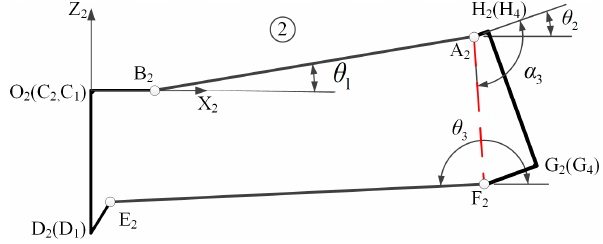
Figure 12. Planar rib mechanism (cid:193)